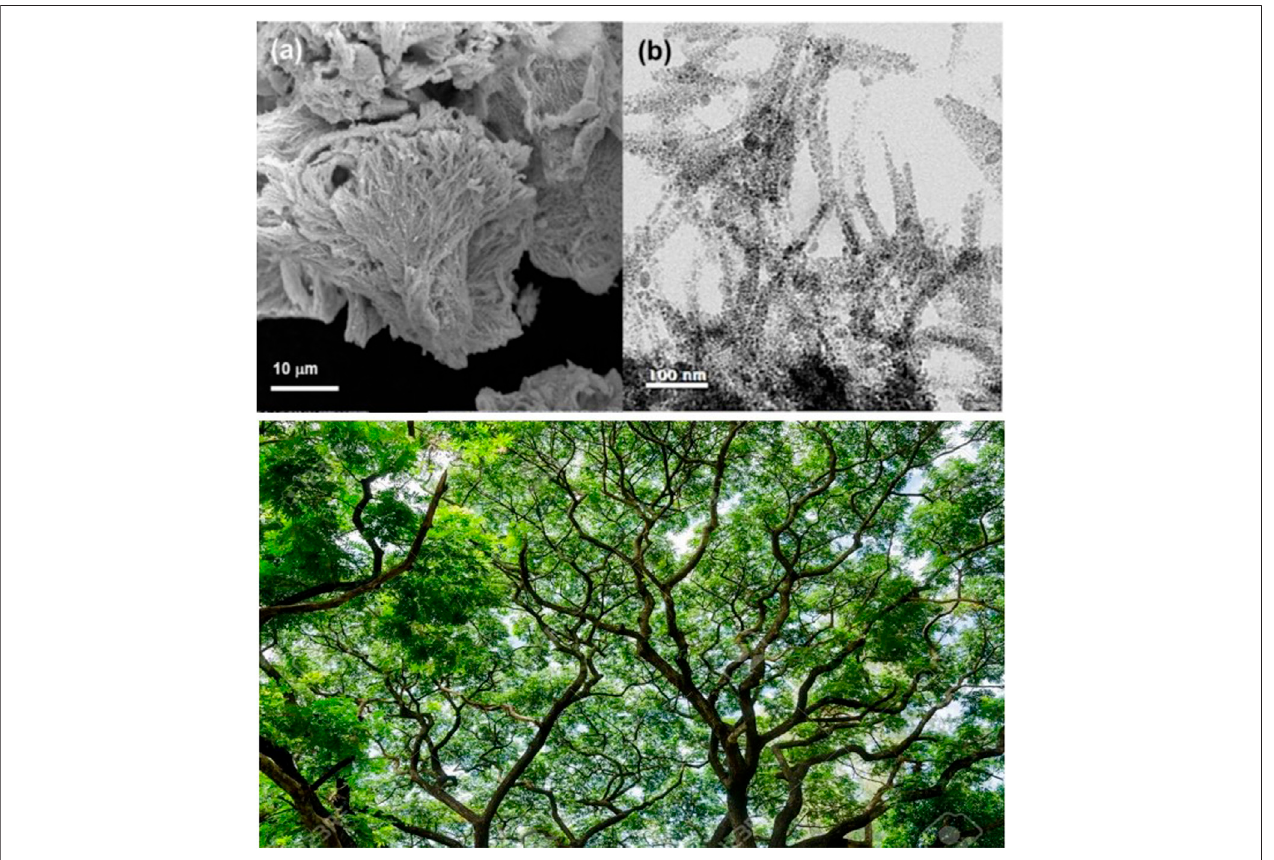
FIGURE 7 | On top are the SEM (A) and TEM (B) images of the HSS conformed by silver nanoparticles. (Reprinted from Elijah T Adesuji et al. Nanotechnology 31 425601. © 2020 IOP Publishing Ltd.). compared to a photograph of the branches of a tree at the bottom (Copyright: Big trees and branches of trees